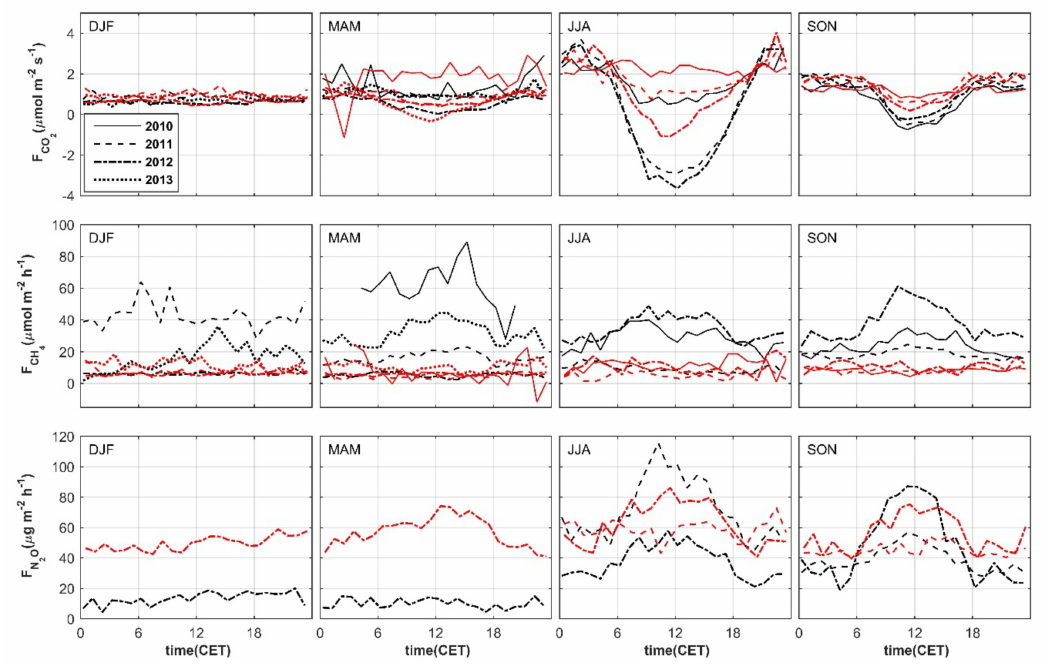
Figure 11. Mean diel GHG exchanges during the winter (DJF), spring (MAM), summer (JJA) and fall (SON) seasons of 2010 to 2013. Black lines represent fluxes at plot 1, while red lines represent fluxes at plot 2. Top panel: CO 2 fluxes; Middle panel: CH 4 fluxes. Lower panel: N 2 O fluxes. Note that the CH 4 fluxes during MAM 2010 are based on only 11 days of data in May and that the N 2 O fluxes during SON 2012 are based on only 27 days of data in